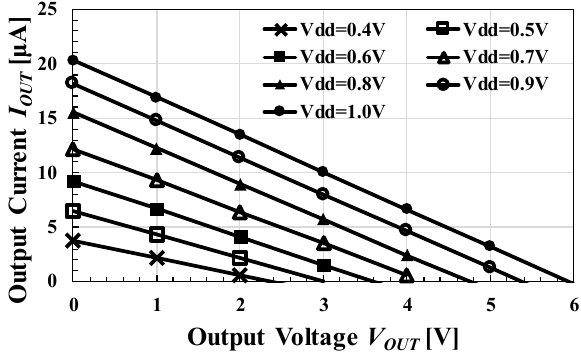
Figure 15. Measured I OUT as a function of V OUT ( f IN = 1 kHz, f CLK = 5 MHz). Electronics 2020 , 9 , x FOR PEER REVIEW